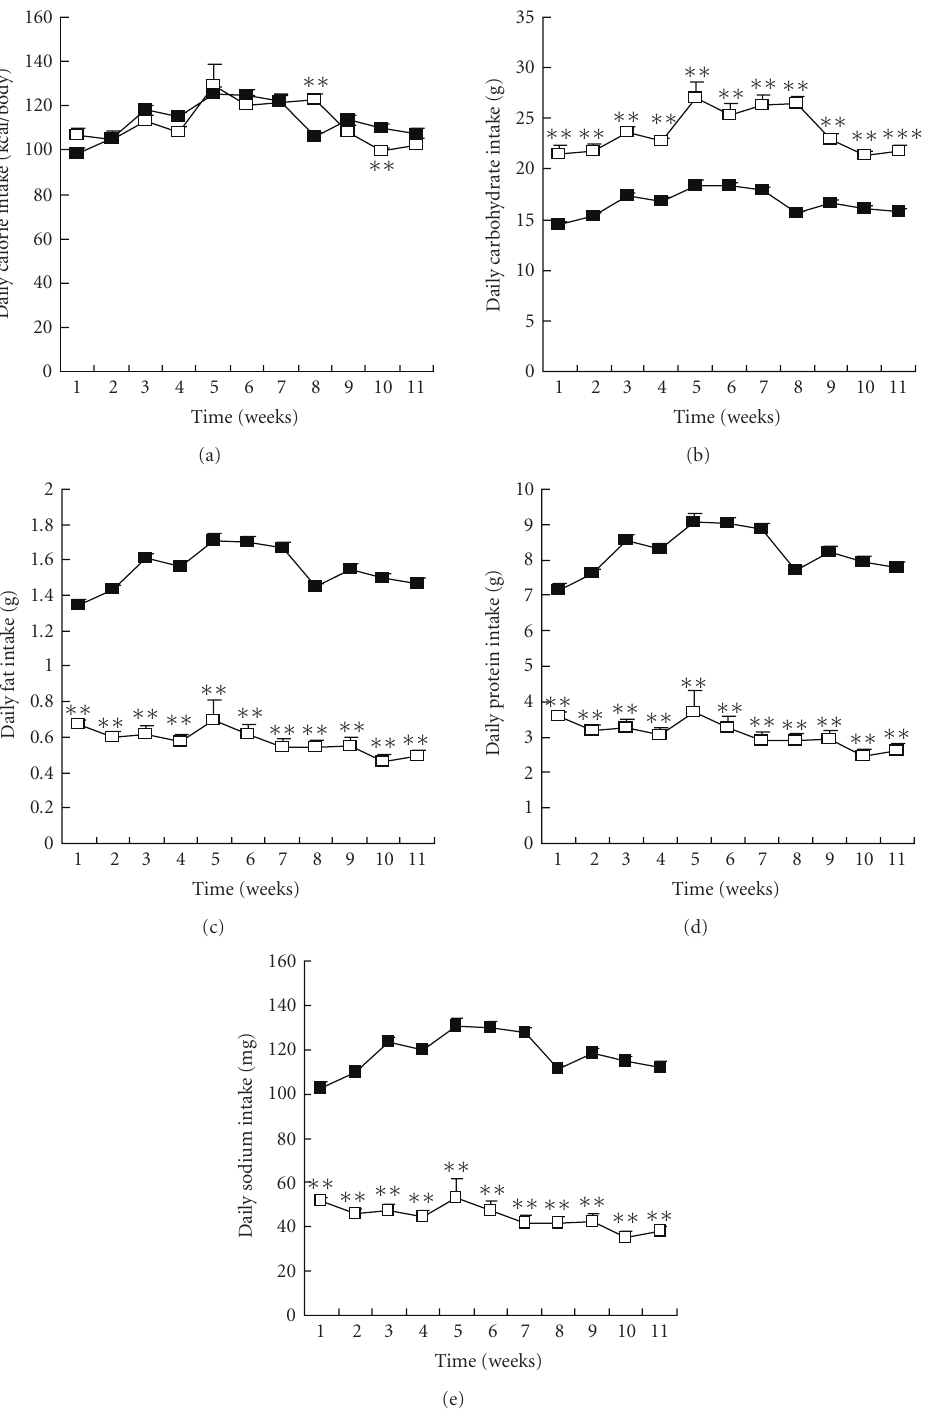
Figure 1: Daily diet intake. (a) Daily calorie intake, (b) carbohydrate intake, (c) fat intake, (d) protein intake, and (e) sodium intake in MC/MF (closed square) and HC/LF (open square). ∗∗ P < . 01, ∗∗∗ P < . 001 versus MC/MF.